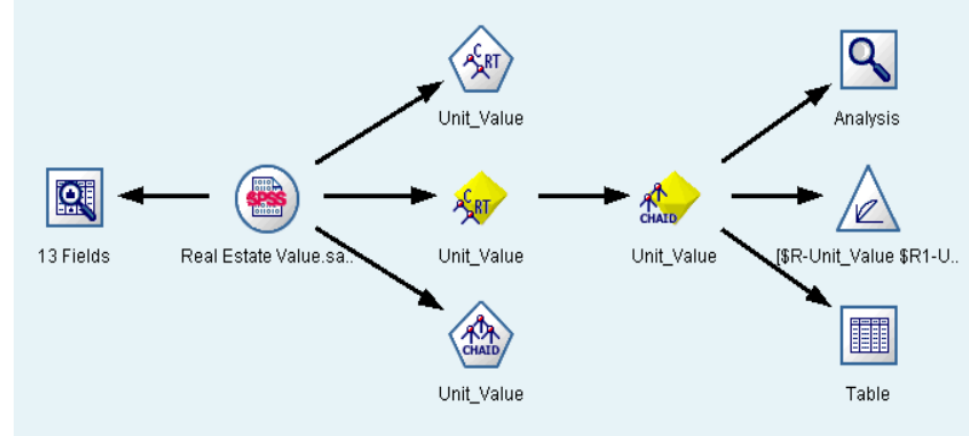
Fig. 5. IBM SPSS Modeler data mining program view (developed by the